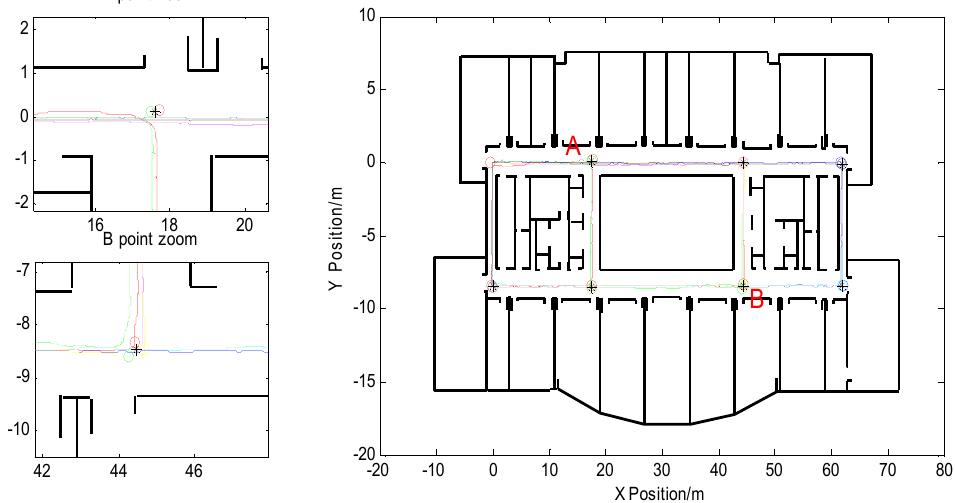
Figure 7. Matching of feature point maps with interior building plans and the details of the two zoomed-in feature points.